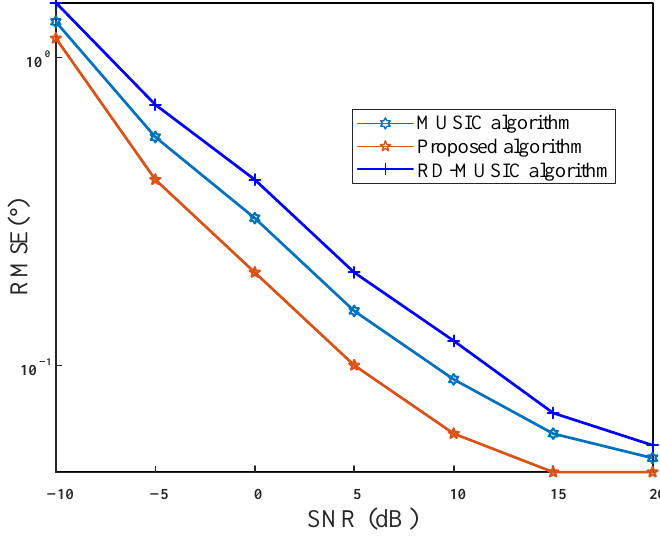
Figure 9. RMSE versus the SNR for phi.